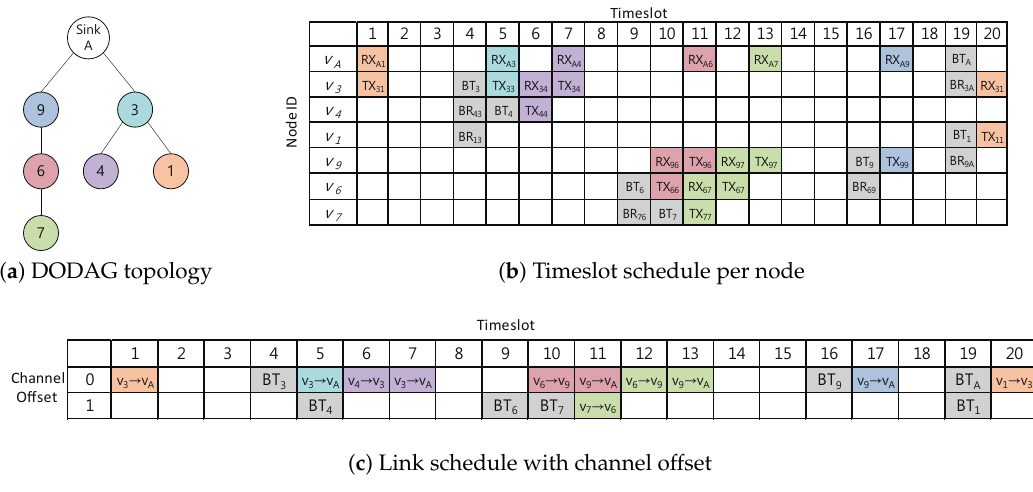
Figure 5. An example of the Escalator schedule. DODAG, Destination-Oriented Directed Acyclic